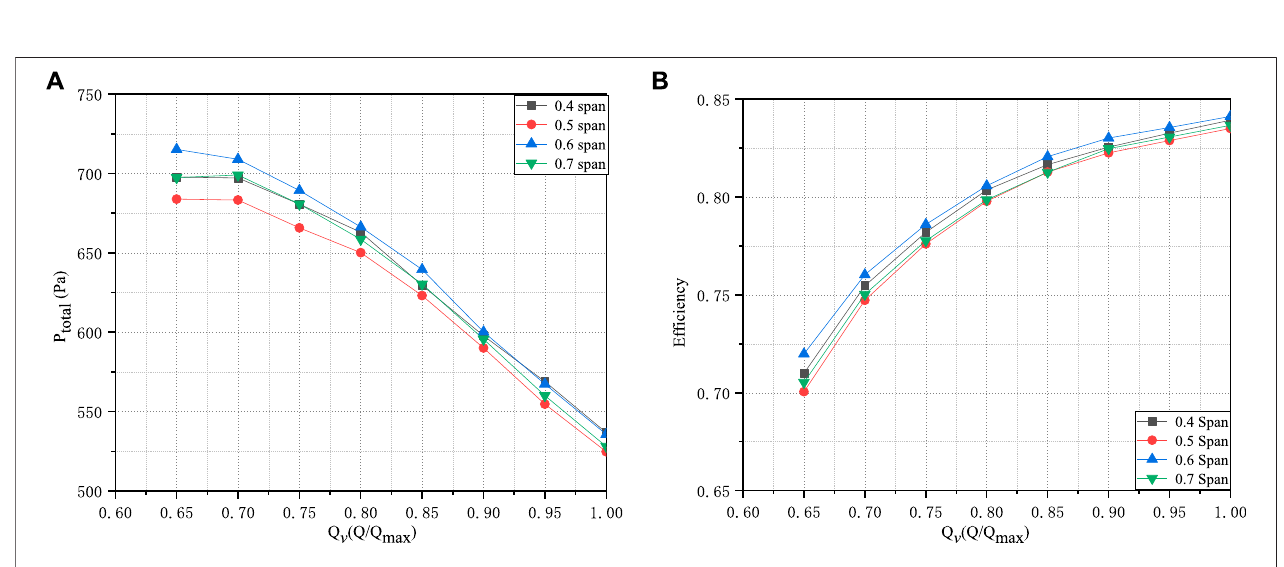
FIGURE 9 | Performance curve of forward-swept blades at different starting heights.